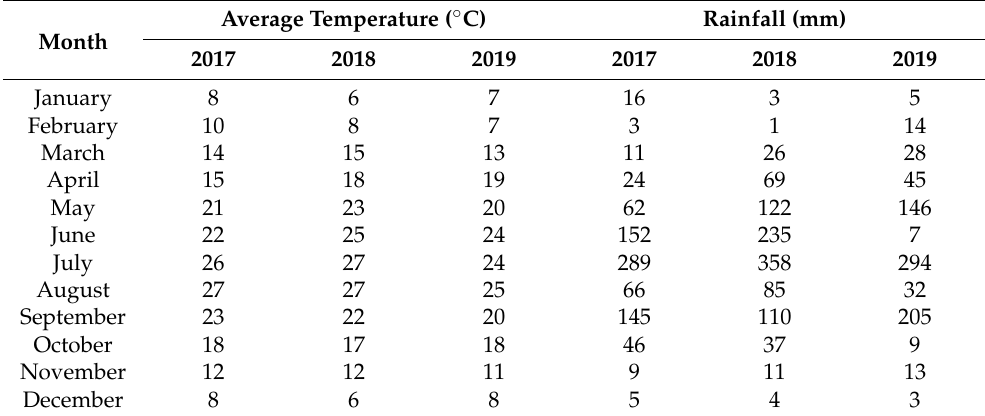
Table 2. Monthly average temperature and sum of rainfall of the experimental site from 2017 to